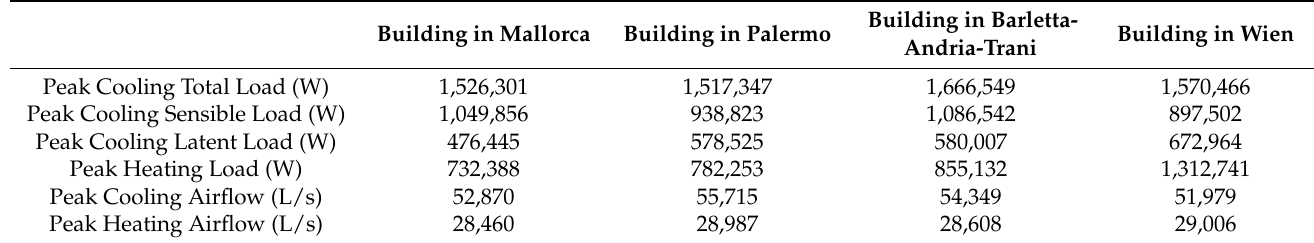
Table 7. Cooling and heating loads and airflow summary table.